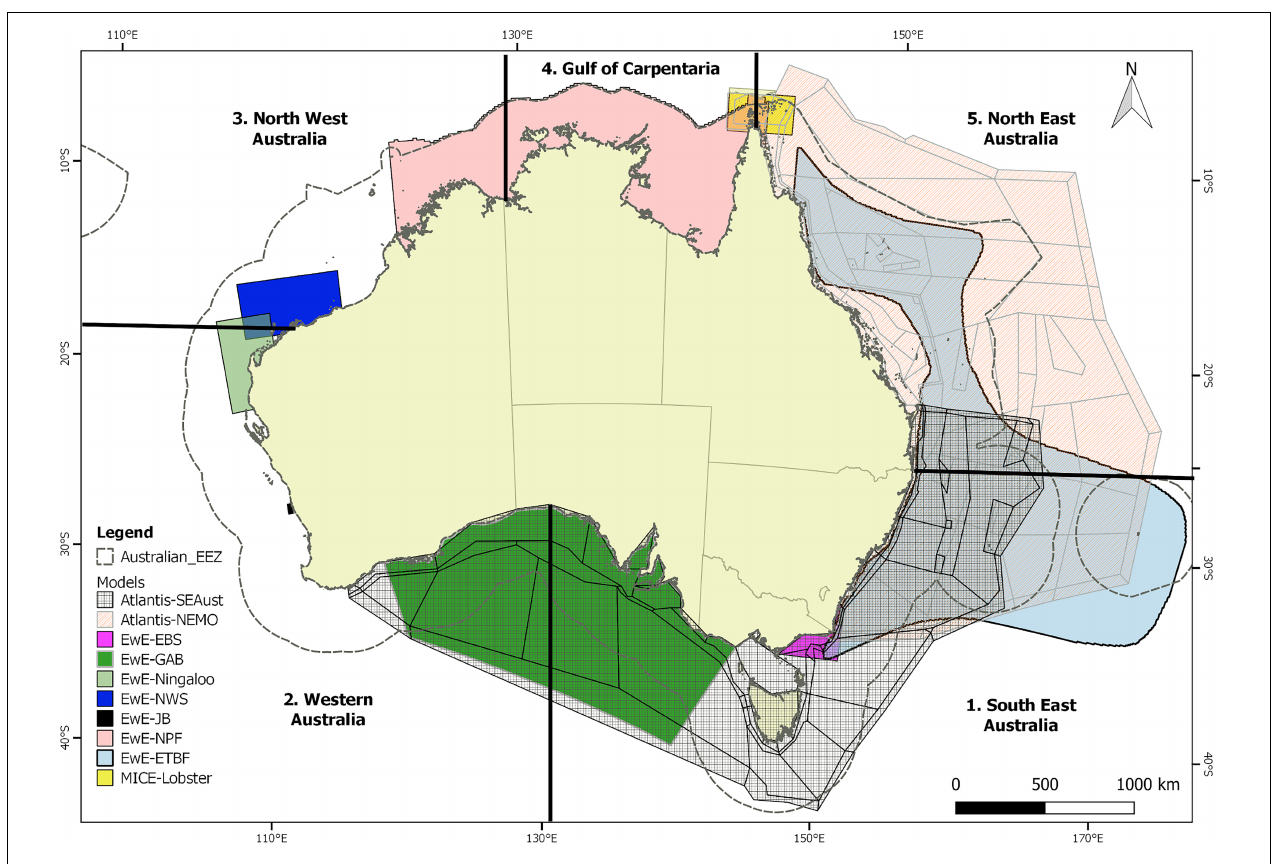
FIGURE 1 | Map showing the regional ecosystem model domains and the 5 assessment regions. The two global modeling platforms are not shown on the map though extracted outputs for each assessment region within the Australian Economic Exclusion Zone